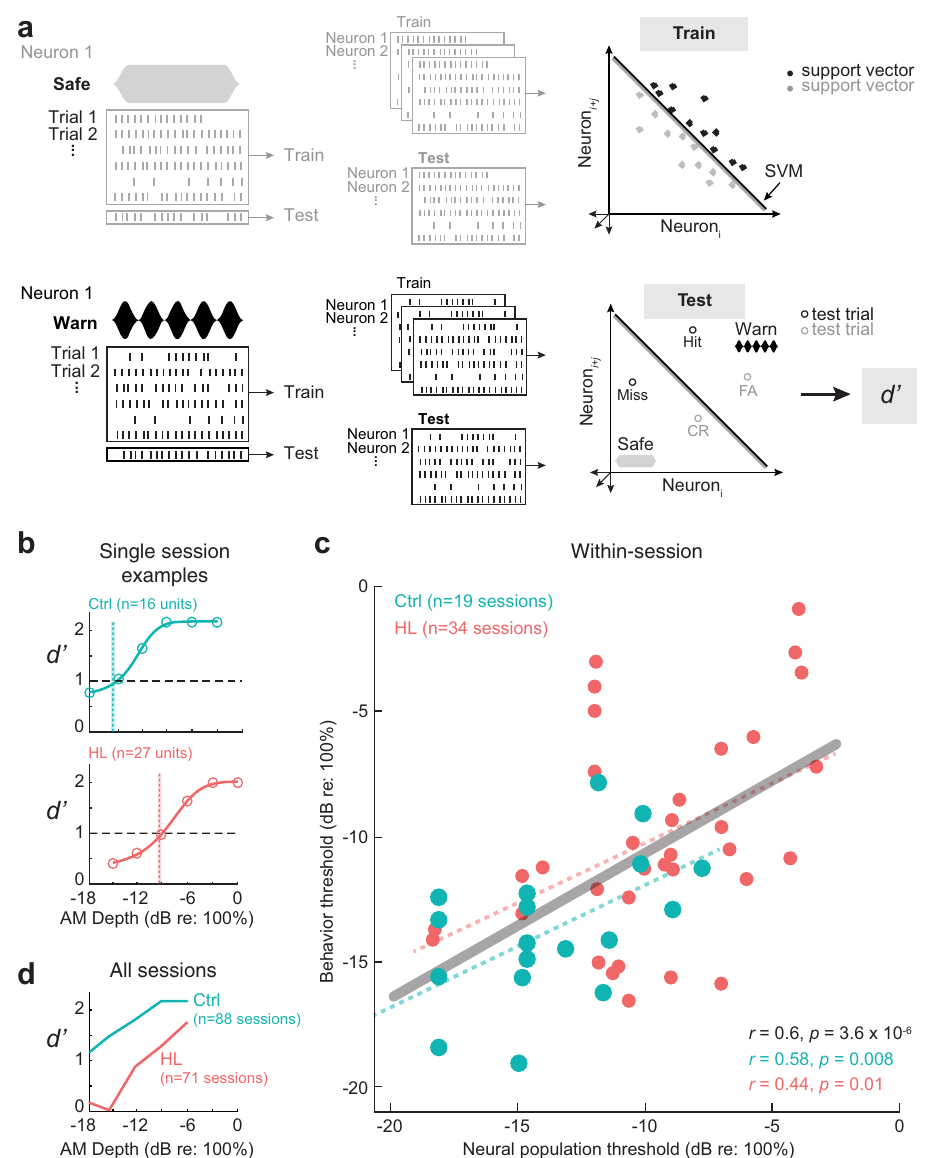
Fig. 6 AC population decoder analysis can explain hearing-loss-related behavioral de fi cits. a Schematic of AC population AM depth encoding with a linear population readout procedure. Hypothetical population responses for individual trials of a Safe (gray; unmodulated) and Warn (black; modulated) stimulus. Spikes were counted across the entire stimulus duration (1 sec) such that spike fi ring responses from N neurons to T trials of S stimuli ( “ Warn ” and “ Safe ” ) formed a population “ response vector ” . A proportion of trials ( “ leave-one-out ” procedure) from each neuron were randomly sampled (without replacement) and fi tted to a linear hyperplane that was determined by a support vector machine (SVM) procedure ( ” train ” set). Symbols represent “ support vectors ” , which are points used to create the linear boundary. Cross-validated classi fi cation performance was assessed on the remaining trials ( “ test ” set). Performance metrics included the proportion of correctly classi fi ed Warn trials ( “ Hits ” ) and misclassi fi ed Safe trials ( “ False Alarms ” ). Similar to the psychometric and individual unit neurometric analyses, we converted population decoder performance metrics into d ′ values. This procedure was conducted across 500 iterations with a new randomly drawn train and test set for each iteration. b Population decoder performance ( d ′ ) for two example individual recording sessions as a function of AM depth from Ctrl and HL neuron populations. Neural d ′ values were fi t with a logistic function (solid line), and threshold is de fi ned as the AM depth where the fi t crosses d ′ = 1. Sample size indicates the number of single and/or multi-units included within that session. Shaded vertical bars indicate the behavioral threshold for that session. c Within-session correlations of behavioral threshold plotted as a function of multi-and single-unit population thresholds for that session. Dotted lines indicate the fi tted linear regression for Ctrl and HL thresholds, and the solid line indicates the linear regression for both groups combined (gray). Pearson ’ s r (two-tailed) and statistical signi fi cance of each fi t are noted in the bottom right corner of each plot. Behavioral sessions were included if they had at least 10 single and/or multi-units for the decoder analysis. d Average population decoder performance as a function of AM depth from Ctrl and HL single unit populations pooled across recording sessions (159 total sessions; 88 Ctrl sessions, 71 HL sessions). Sessions were included if there were ≥ 8 trials per